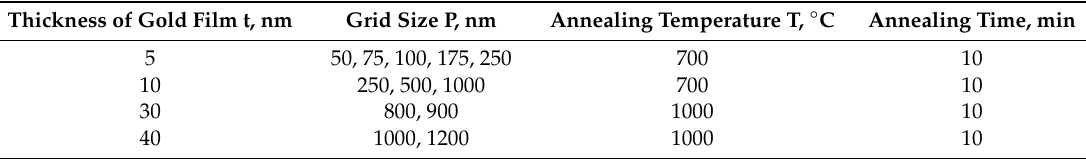
Figure 2. Nano plastic-forming device and knife edge tool made of single crystal diamond. ( a ) whole image of the device; ( b ) optical microscope image of the tool; ( c ) illustration for nanogroove fabrication method. Table 1. Experimental conditions of first-layer nanodot array.